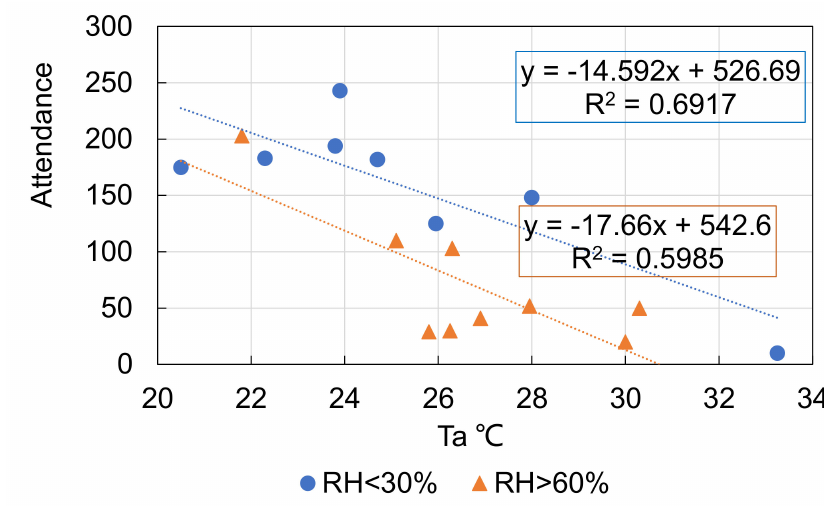
Figure 10. RH level’s influence on the attendance of optional activities when T a > 20 ◦ C.